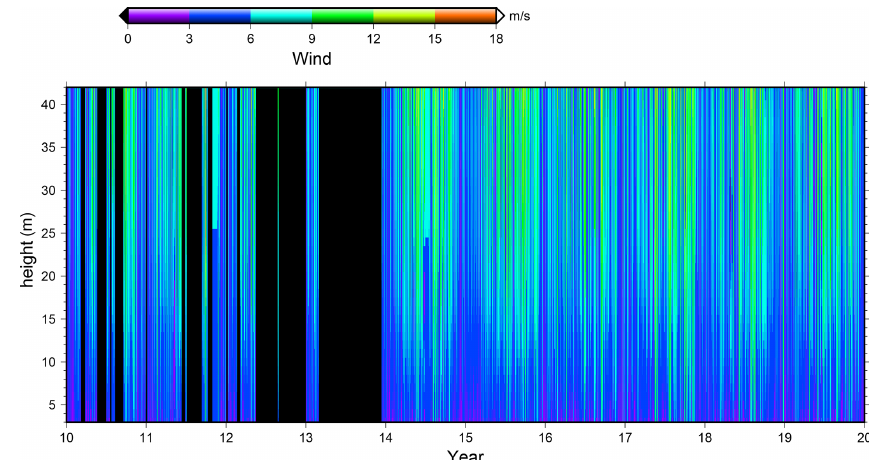
Figure 8. 10-year evolution of daily-mean wind speed in ms − 1 , between 3 and 42m above the surface, from 2010 to 2019. Black shading shows major periods for which data are discarded during quality control or missing (see Sect. 2).